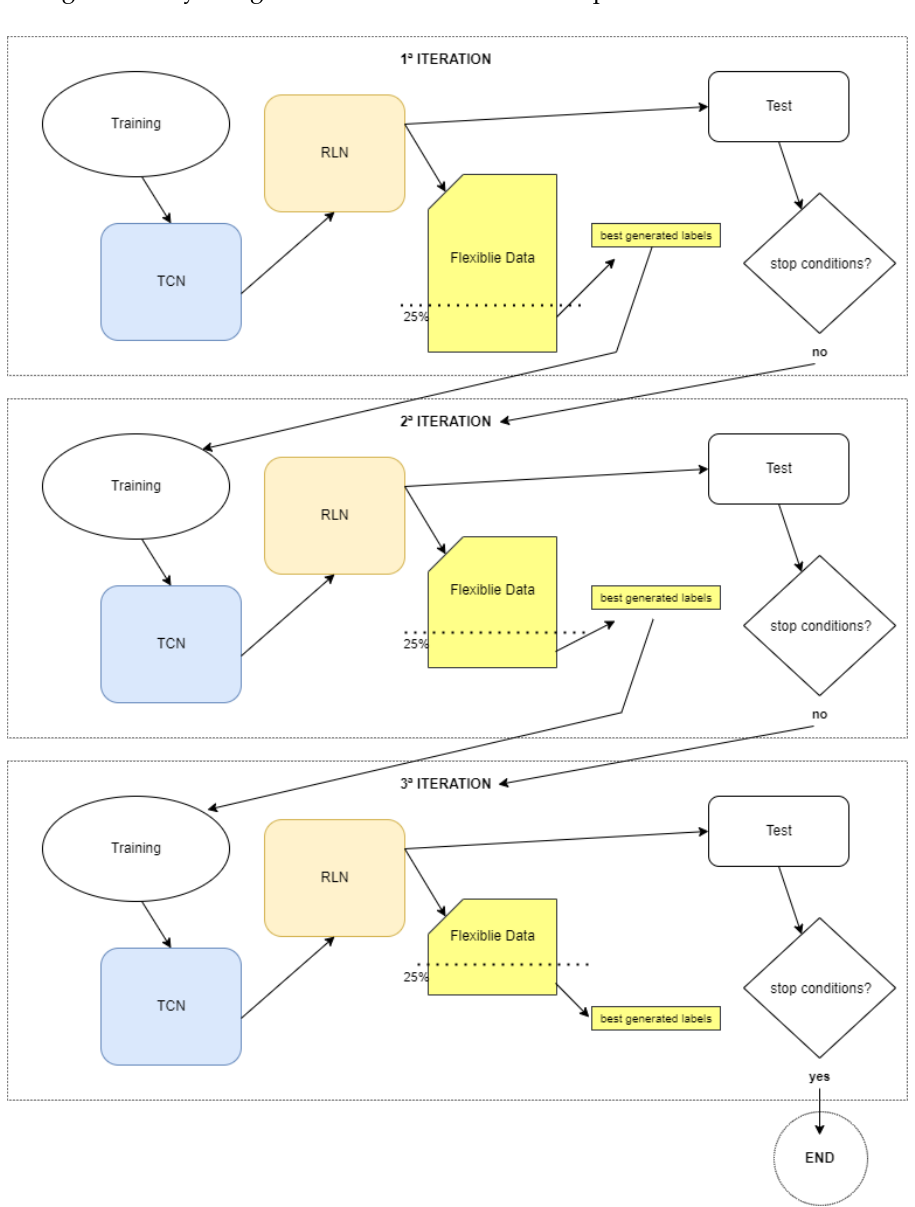
Figure 2. RL-SSI standard execution